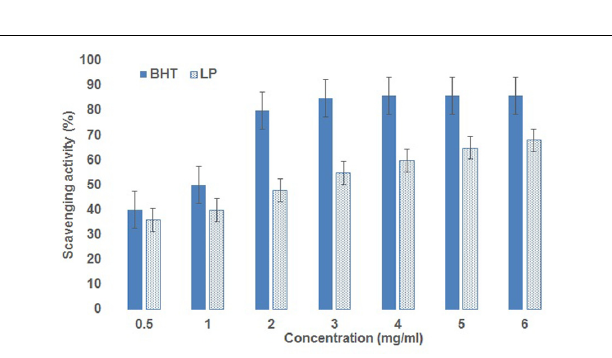
FIGURE 4 | Antioxidant activity of lipopeptide, the activity increases with the concentration of